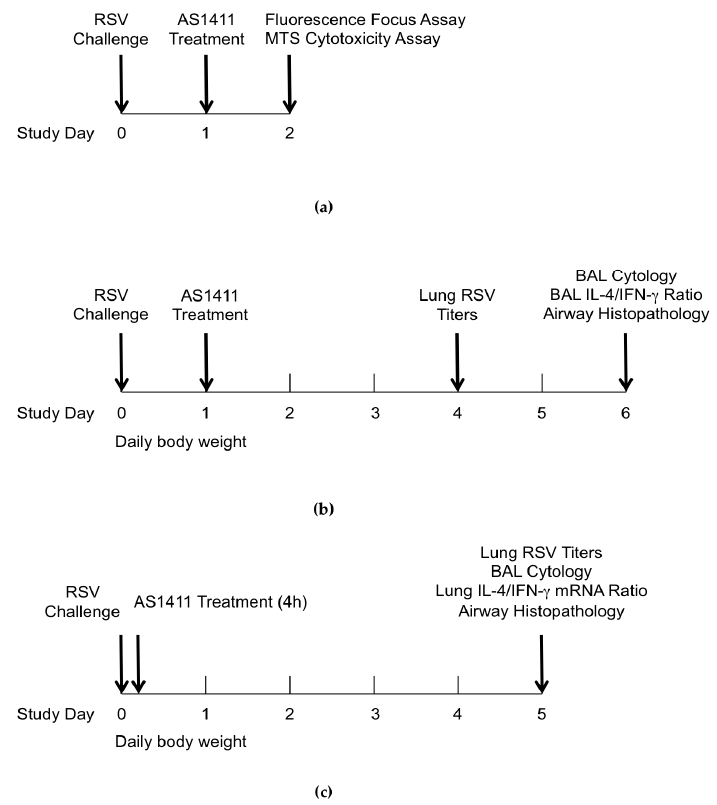
Figure 1. General study design. ( a ) In Vitro experiments with respiratory syncytial virus (RSV)-infected HEp-2 and MDCK cell cultures; ( b ) In Vivo experiments in mouse model; ( c ) In Vivo experiments in cotton rat model. BAL: bronchoalveolar lavage.